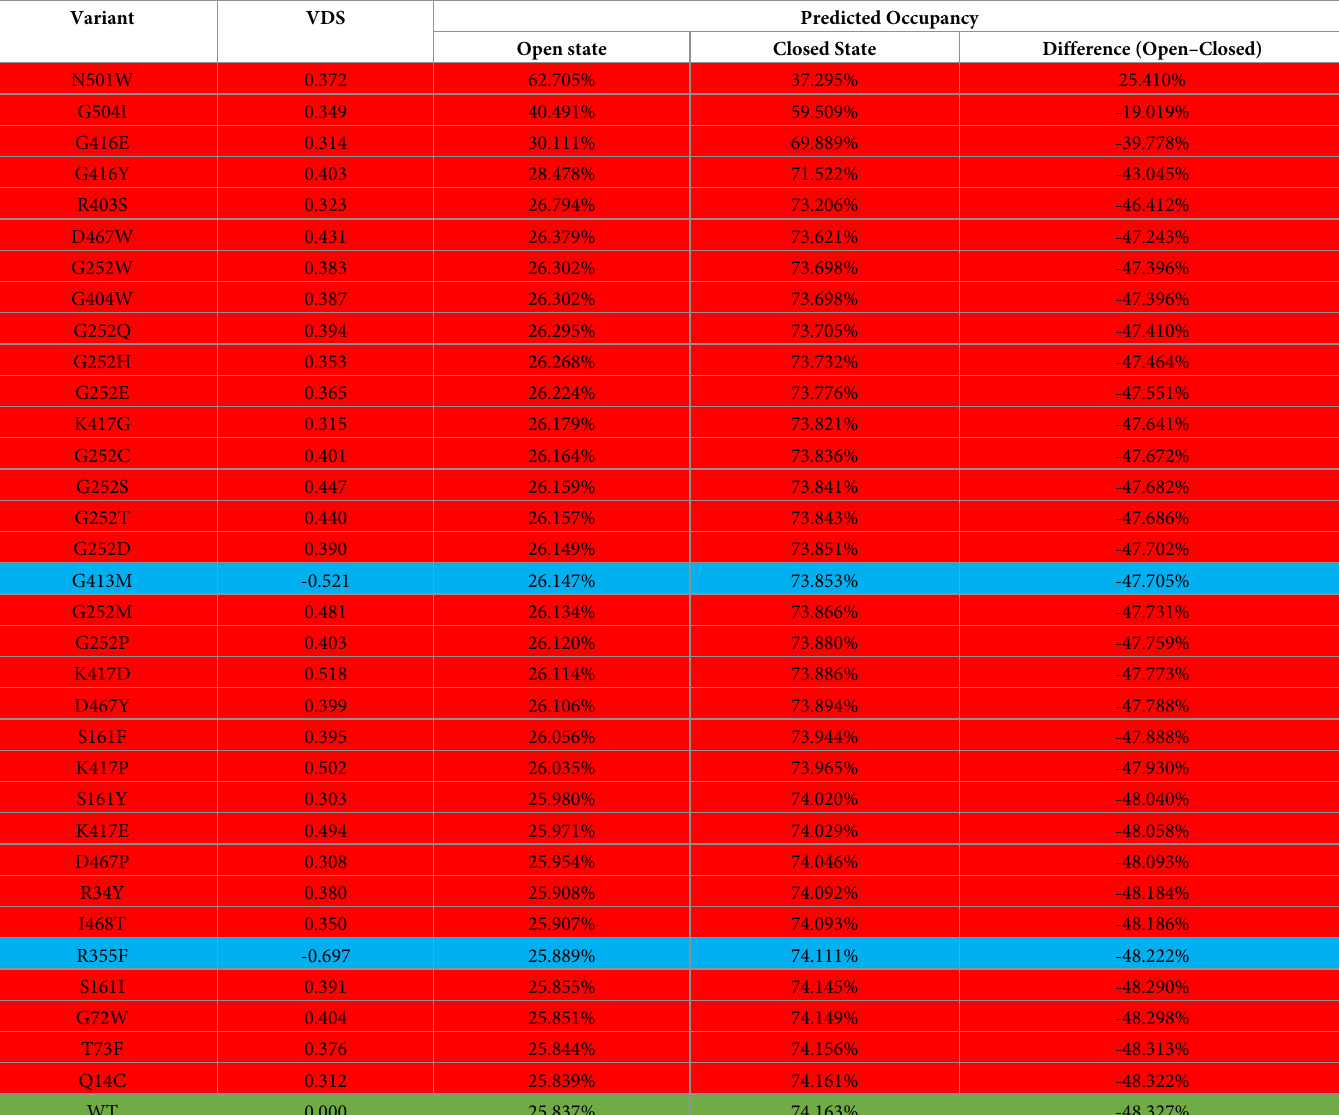
Table 1. Putative mutations, associated VDS ( Δ S vib (open) − Δ S vib (close) , in units of J.K -1 ) and predicted occupancies for the open and closed states for the mutants with predicted open-state occupancy higher than that of the wild type. Predicted occupancy values are shown for the open conformation, the closed conformation, and the difference between the two (closed–open). The data for the remaining mutants with occupancy below that of the wild type but VDS > 0.3 (red) as well as those with the lowest predicted VDS values (blue) is presented in S3